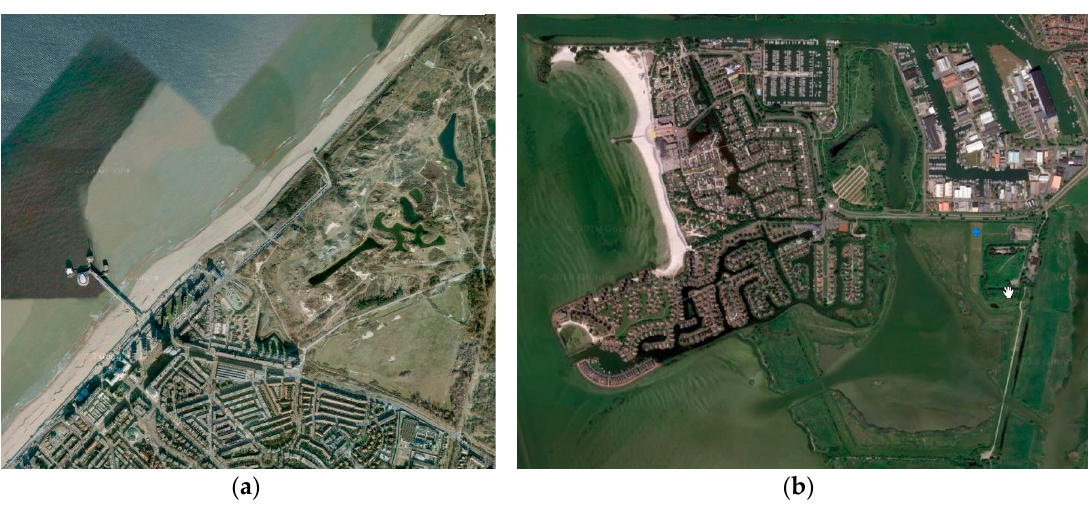
Figure 12. ( a ) Town adjacent to coast; ( b ) Boat house in an island.